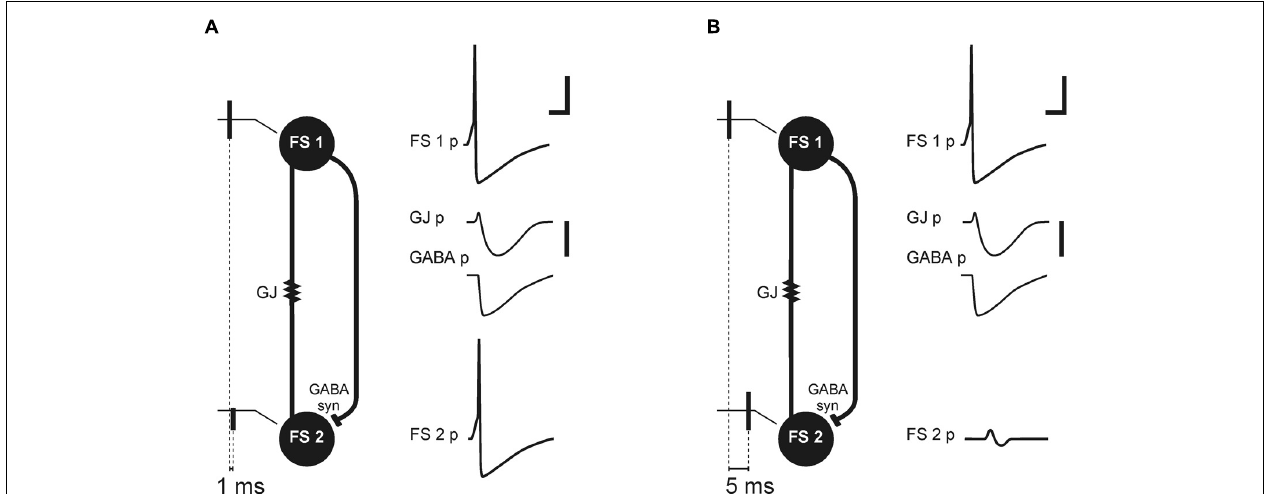
from FS 1 to FS 2. (A) Afferent threshold inputs to FS 1 and FS 2 succeed one another by 1 ms. FS 2 generates an action potential (FS 2 potential, FS 2 p) before inhibition mediated by the GJ and GABAergic synapse. (B) Afferent threshold inputs to FS 1 and FS 2 succeed one another by 5 ms. Excitation in FS 2 is attenuated by hyperpolarization mediated through the GJ and GABAergic synapse (FS 2 p). Scale bars: 20 mV for FS cells membrane potential, 1 mV for potentials mediated by electrical and chemical synapse, 5